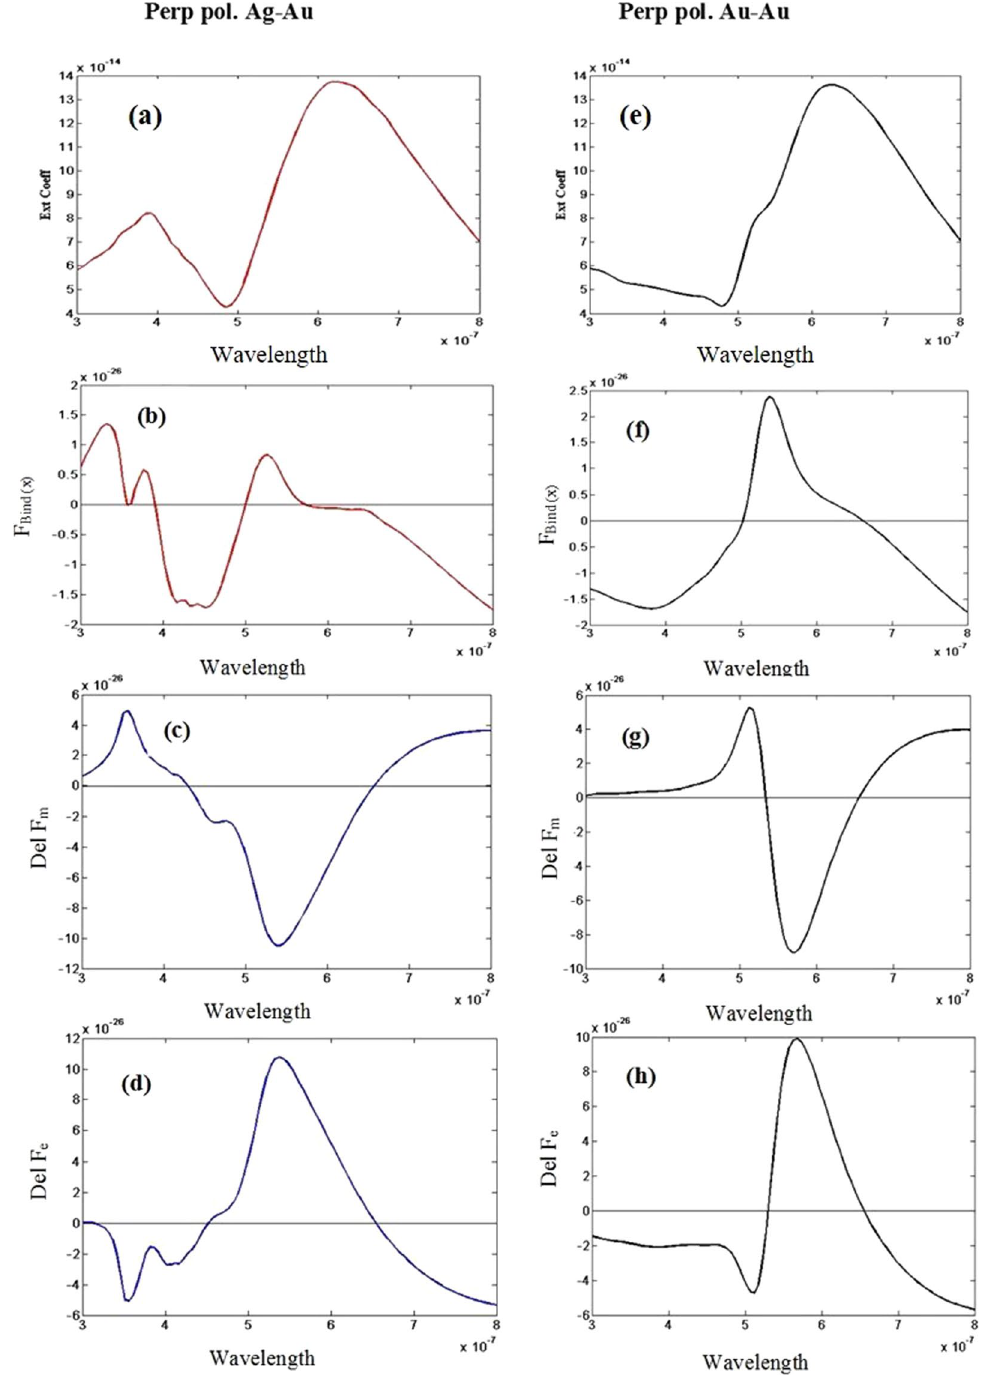
Figure 3. All wavelengths are in meter (m) unit. All Forces are in Newton (N) unit. Considering perpendicular polarized light for the configuration of Fig. 1(a) and ‘ ȹ ’ = 0 degree [on axis Ag-Au]: ( a ) Extinction co-efficient. ( b ) The lateral binding force F Bind(x) = (F B(x) − F S(x) ). ( c ) Difference of bulk Lorentz force. ( d ) Difference of surface force. Considering same polarization of light for the configuration of Fig. 1(b) and ‘ ȹ ’ = 0 degree [on axis Au- Au]: ( e ) Extinction co-efficient ( f ) The lateral binding force F Bind(x) = (F B(x) − F S(x) ) ( g ) Difference of Lorentz bulk force. ( h ) Difference of Lorentz surface